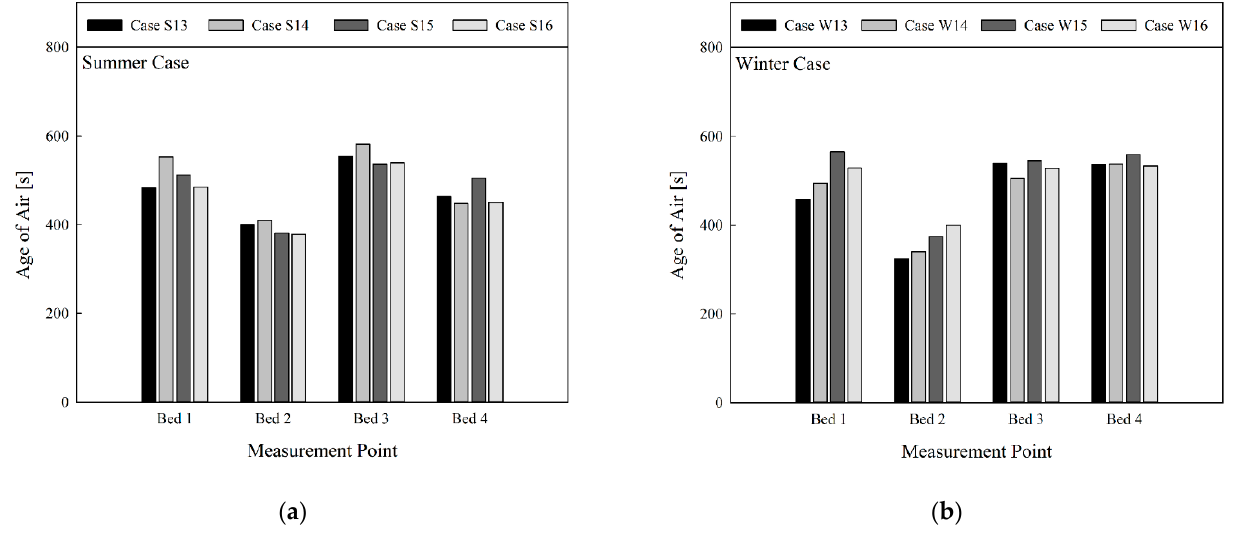
Figure 9. Comparison of age of air at bed location by season (in cases of ventilation system operation, four-way cassette fan coil unit operation, operation of air cleaner, and use of curtain): ( a ) summer; ( b ) winter.